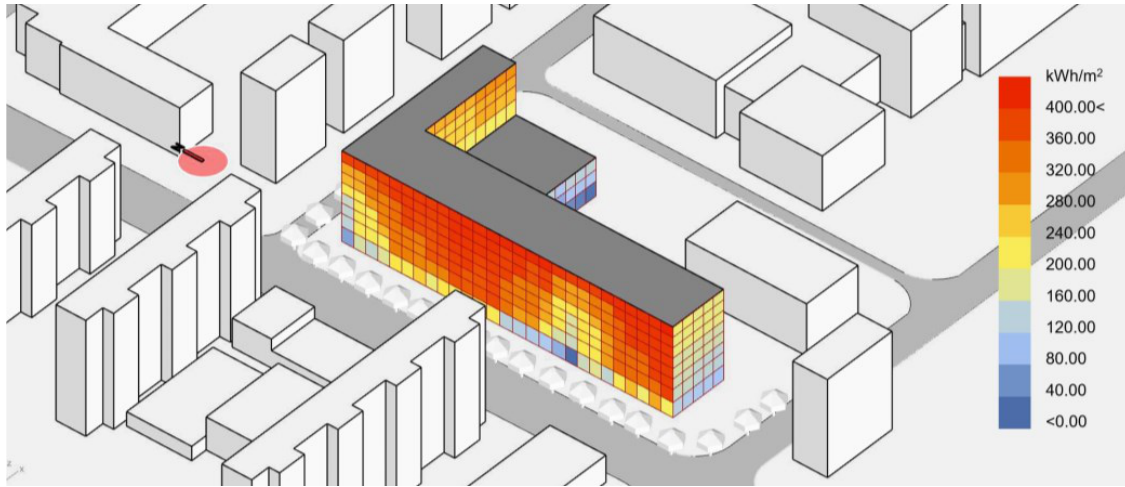
Figure 10. Year-round periodic radiation simulation based on window units.